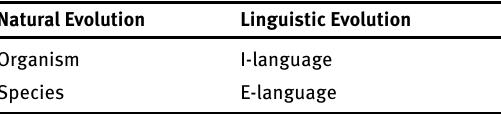
Table 2: Correlation between natural and linguistic evolution (first version) Natural